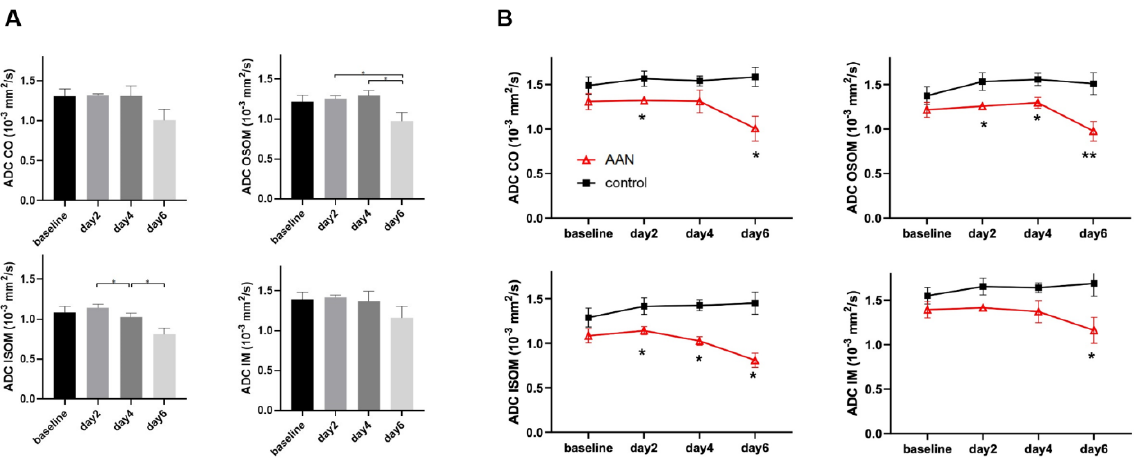
Figure 5. Statistical analysis of apparent water diffusion coefficients (ADCs) for the AAN group ( A ) and the control group ( B ). ** p < 0.01, * p < 0.05. CO, cortex; OSOM, outer stripe of outer medulla; ISOM, inner stripe of outer medulla; IM, inner medulla.